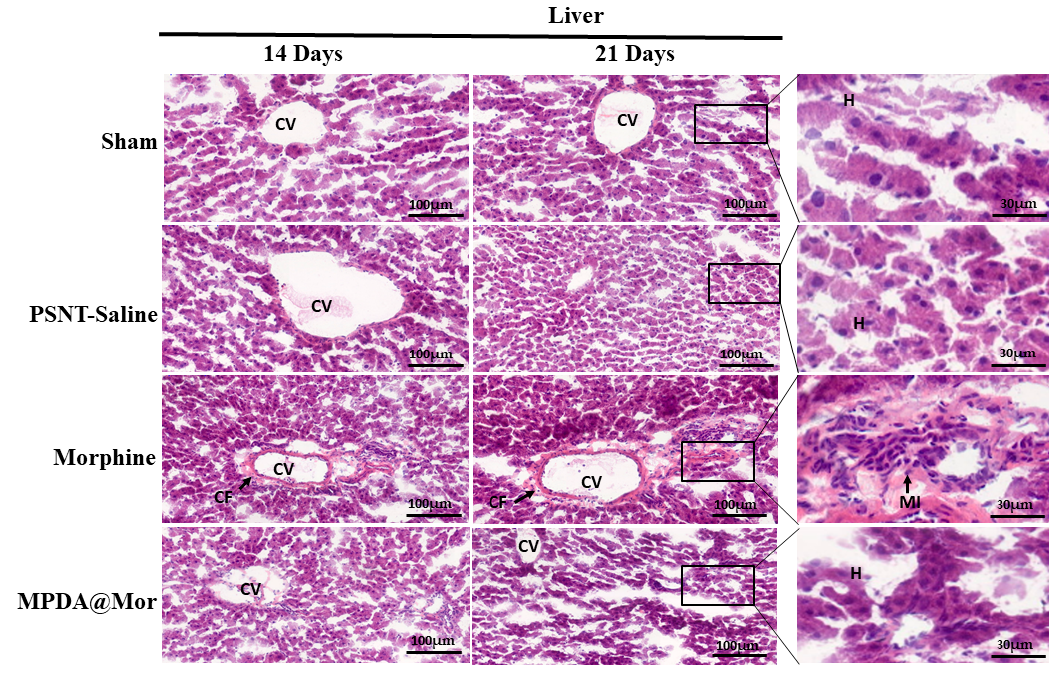
Figure 8. Hematoxylin and eosin stained cross-sections of the liver tissues of Sham, PSNT, morphine and MPDA@Mor groups, (Scale bar = 100 μ M).